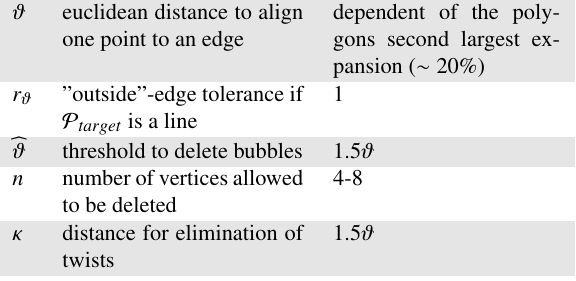
one of the surrounding plane segments (right). Table 2. Table of given alignment thresholds with short descrip- tion and empirically determined decision rule. The values are given in pixels by building polygons of a resolution of around 15cm per pixel.